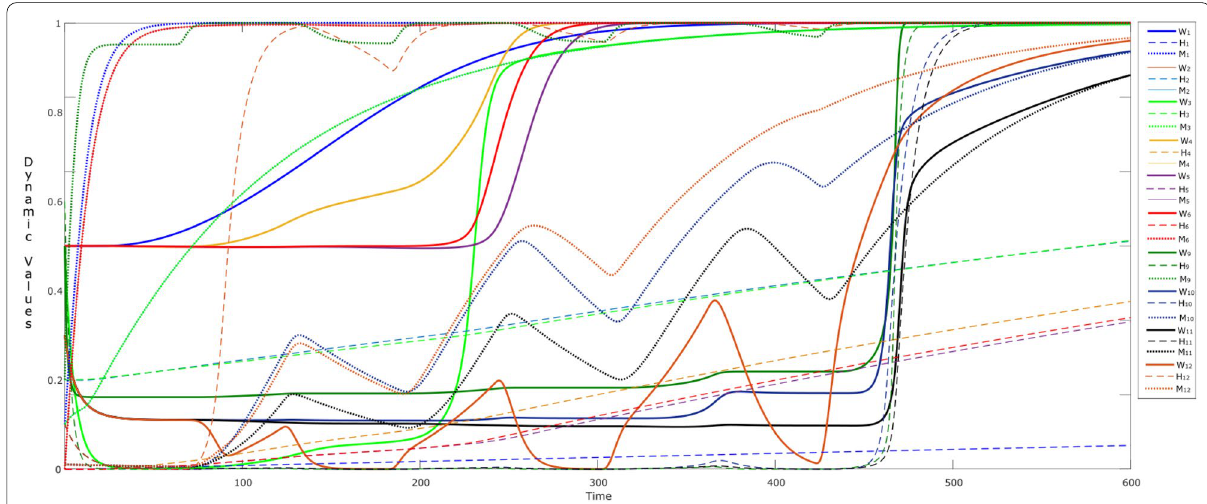
Fig. 5 W-states during the alternative episodes addressed in Fig. 4